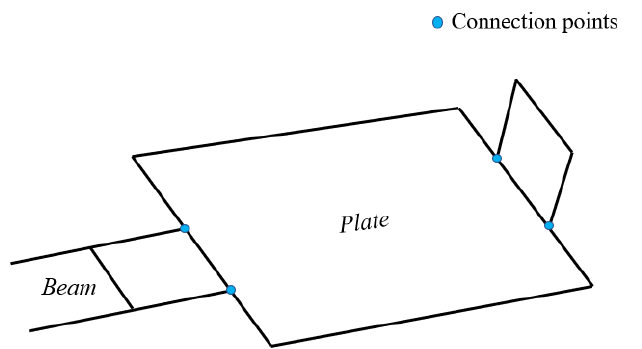
Figure 8. Parent structure connected to substructures with slave degrees of